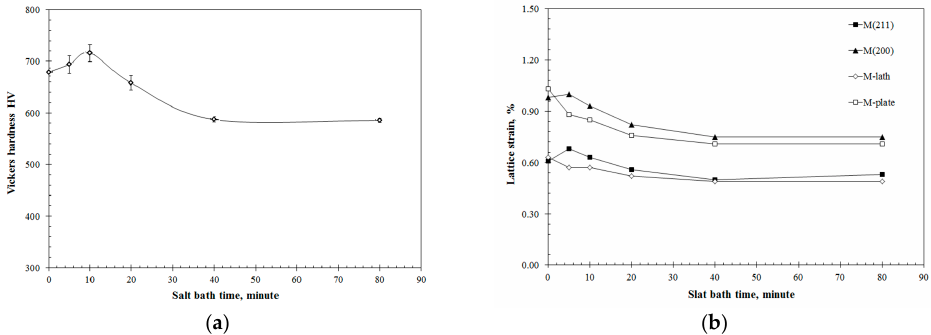
Figure 1. Effect of austempering time on ( a ) the hardness property of the sample steel and ( b ) the lattice strains of the martensitic and bainitic ferrites.